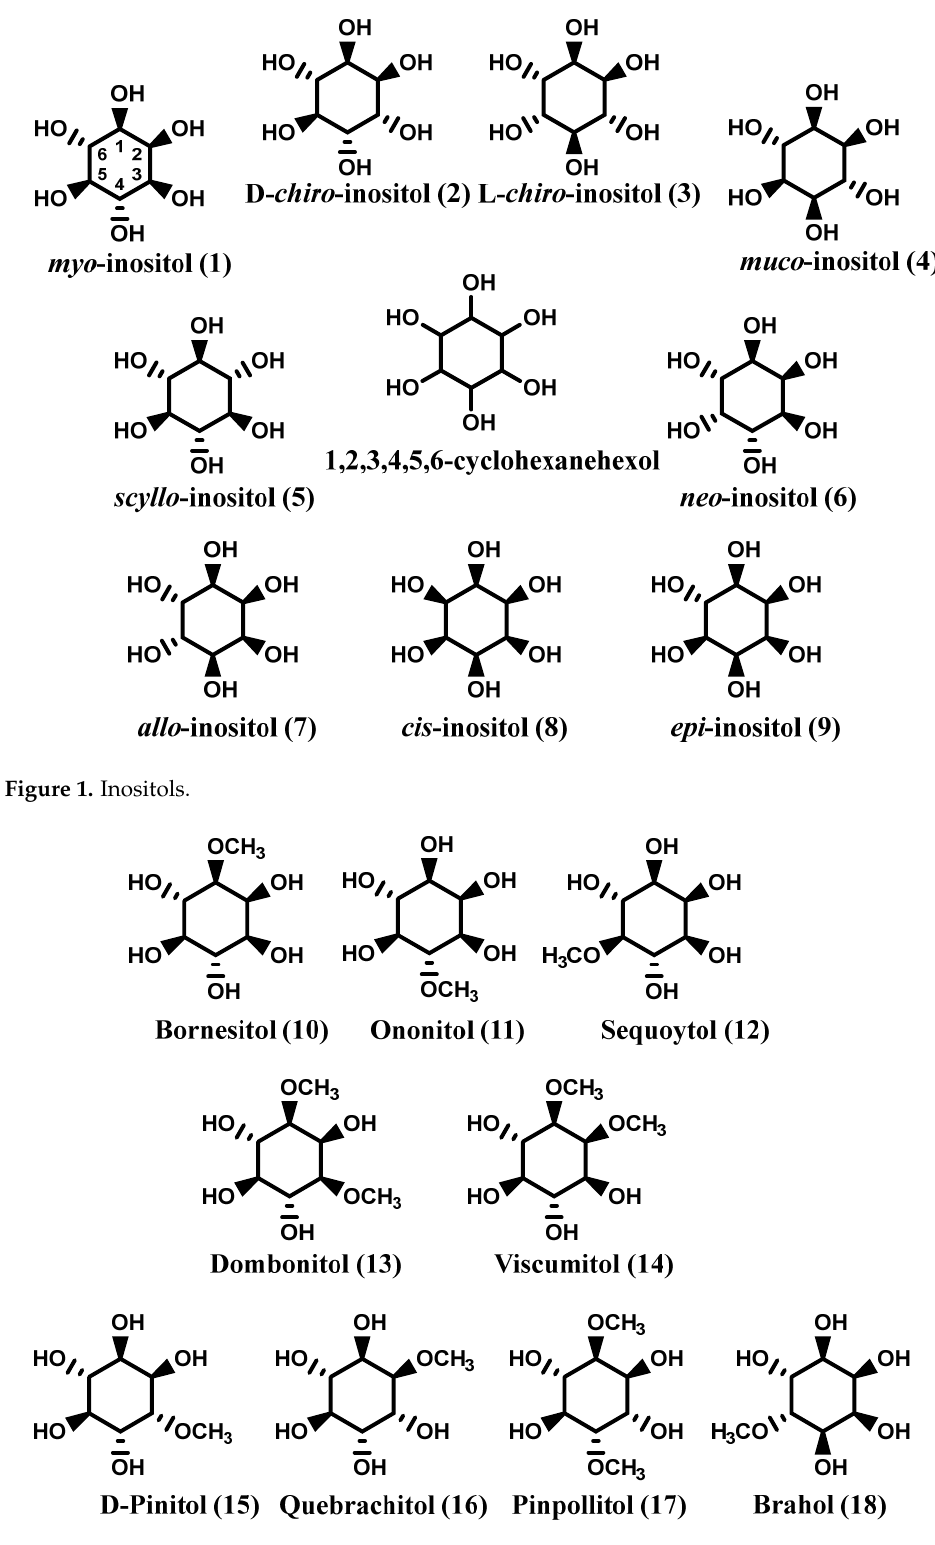
Figure 2. Methyl ethers derivatives of inositols.